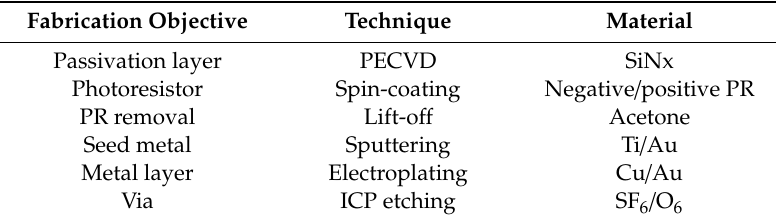
Table 1. Manufacturing techniques used in the IPDs process.